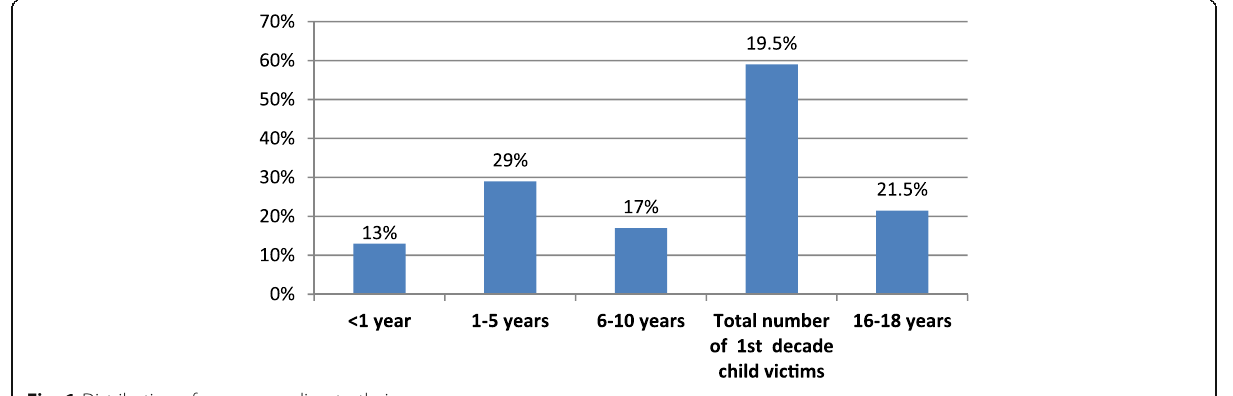
Fig. 1 Distribution of cases according to their age